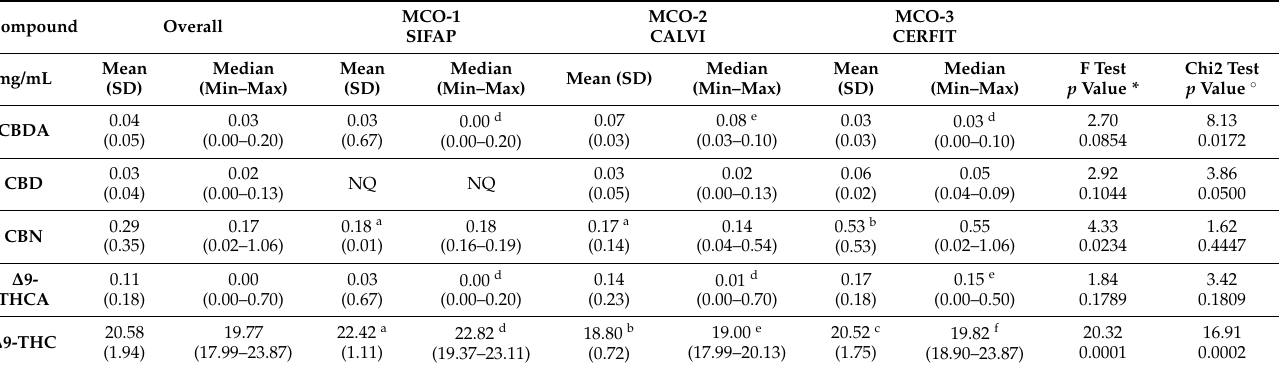
Table 7. Cannabinoids (mg/mL) in MC extracts. Data from ten separate experiments each performed in triplicate. Tukey-Kramer (for One-Way ANOVA) or Dunn (for Kruskal-Wallis test) post-hoc analyses were applied. Differences were considered significant when p < 0.05 and are indicated with different superscripts letters: in each line, values with a different letter (a, b or c for mean values; d, e or f for median values) are significantly different ( p < 0.05).